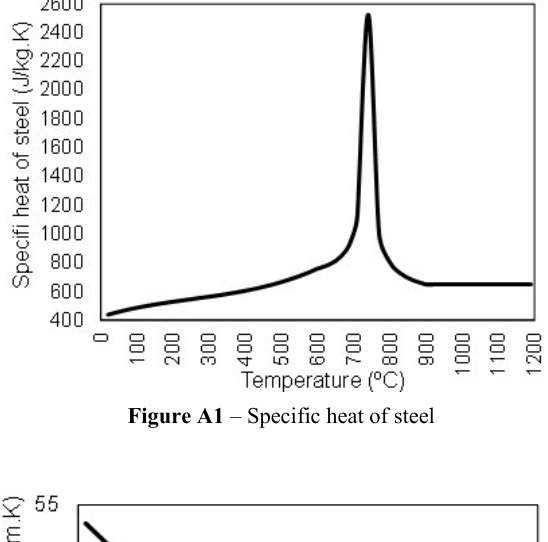
Figure A1 – Specific heat of steel